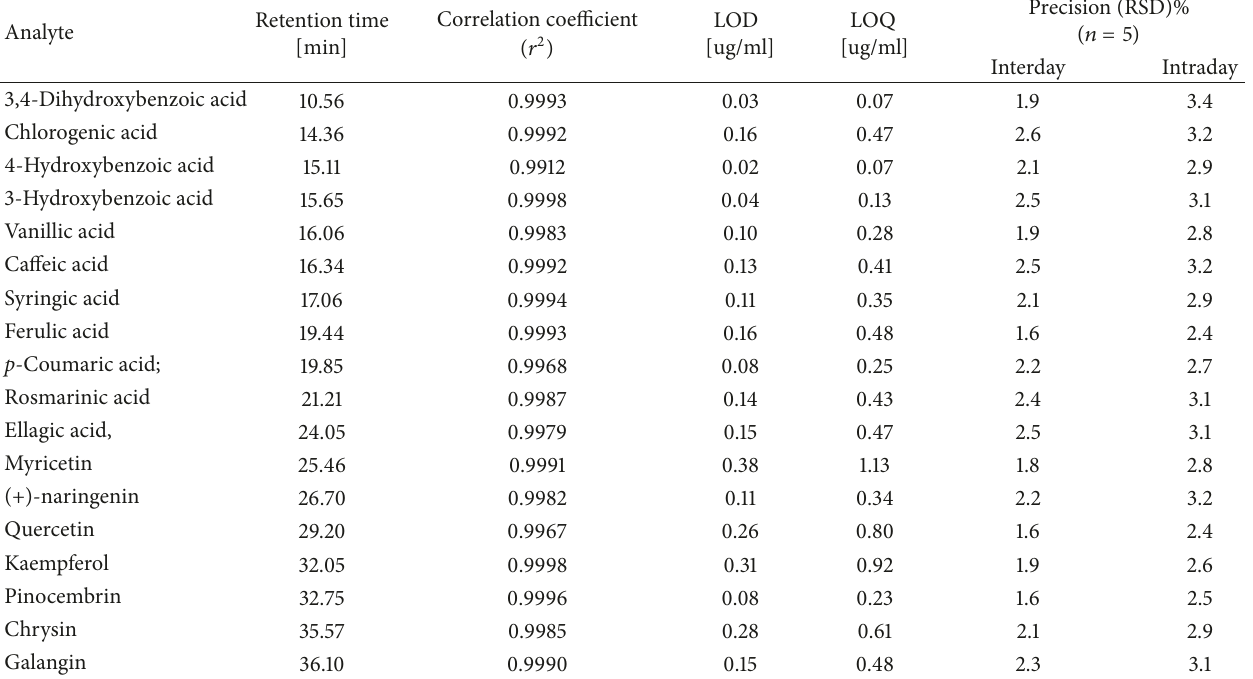
Table 2: Calibration curves and detection limits of studied flavonoids and phenolic acids for HPLC-PAD